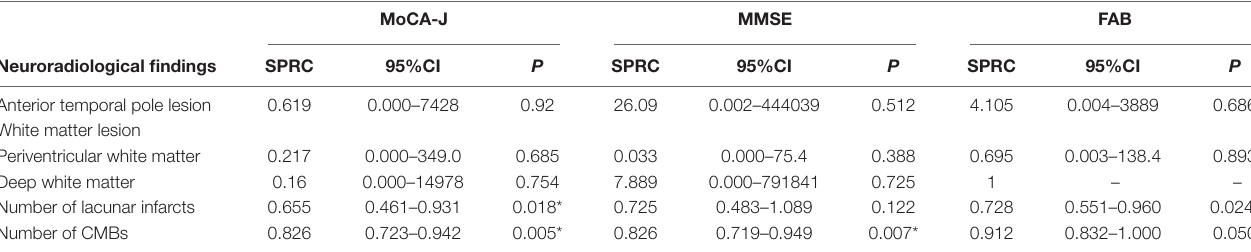
TABLE 4 | Factors associated with neuropsychological tests.